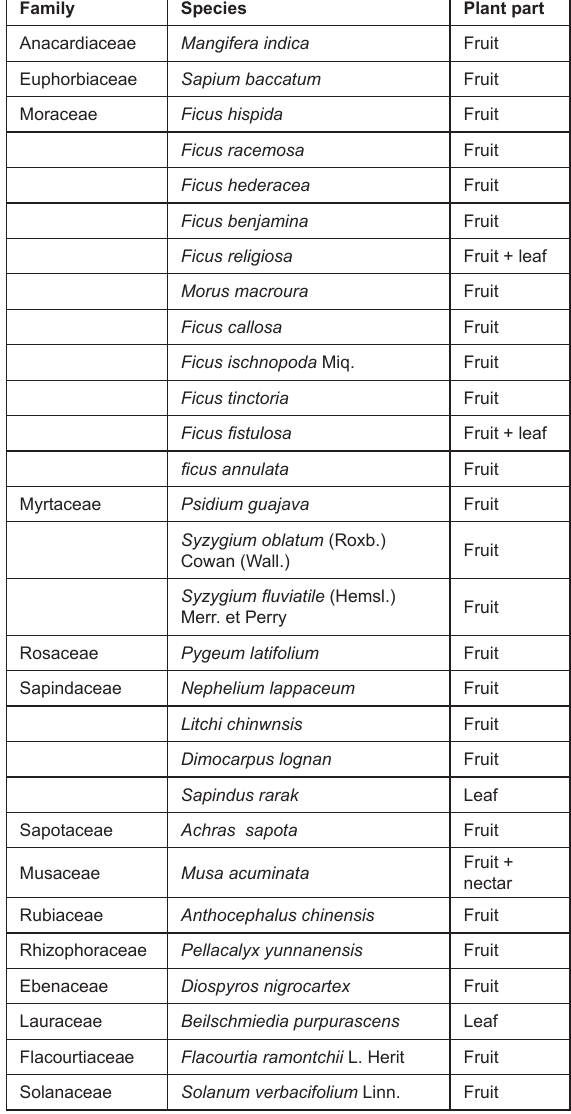
Table 2. The plant exploited by C. sphinx in Xishuangbanna Tropical Botanical